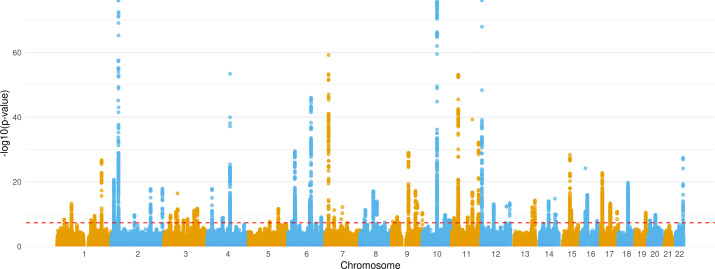
Manhattan plot showing distribution of p-values from genome-wide association study of calculated free testosterone after exclusion of SHBG-associated variants based on chromosomal location.